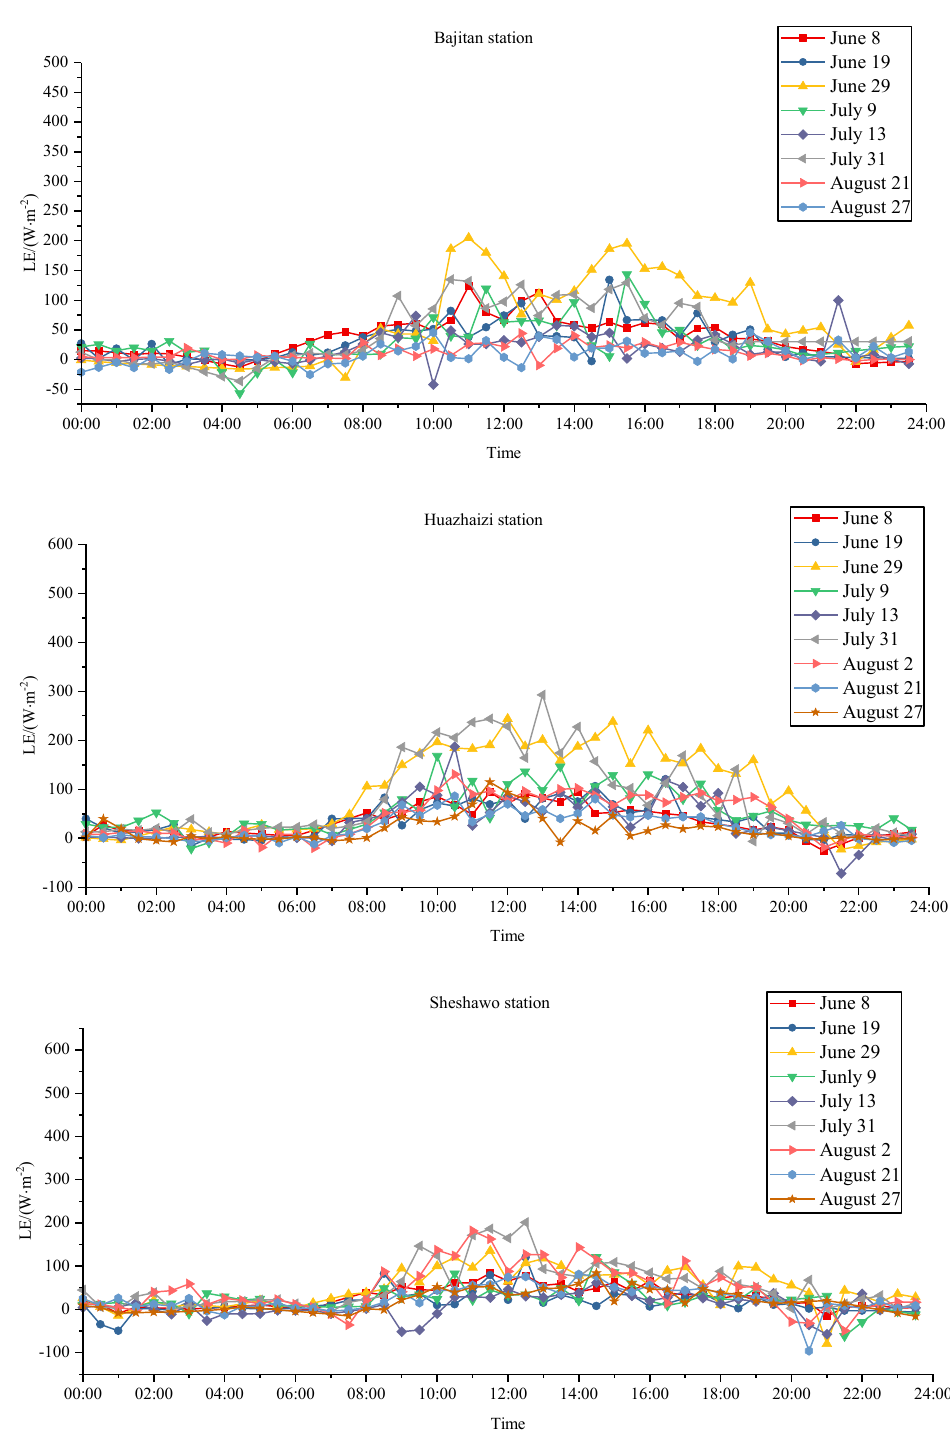
Figure 6. LE intraday variation trend of nine days under different underlying surface types.